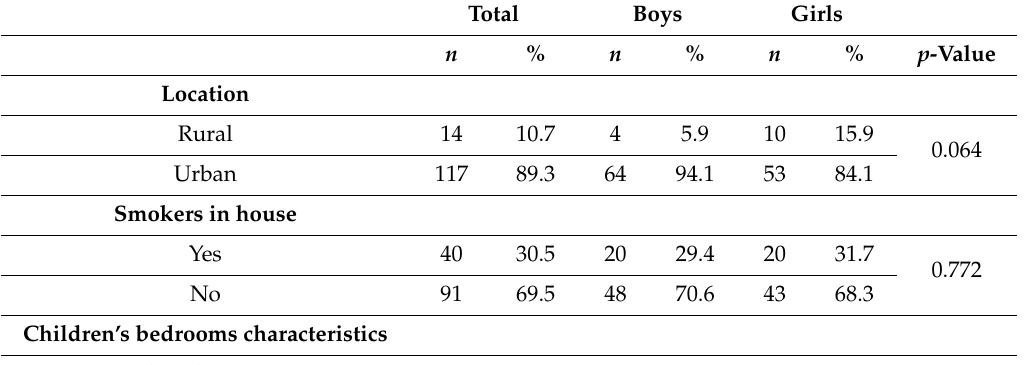
Table 2. Bedroom characteristics ( n = 131) (adapted from: